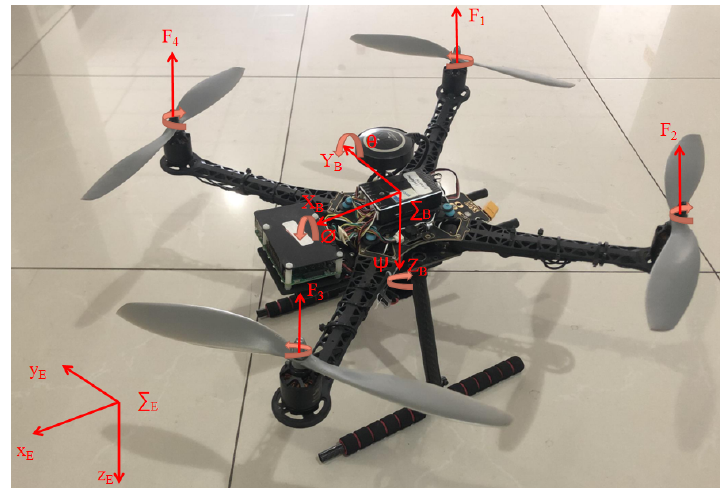
Figure 1. Structure and coordinate system of quadrotor unmanned aerial vehicle